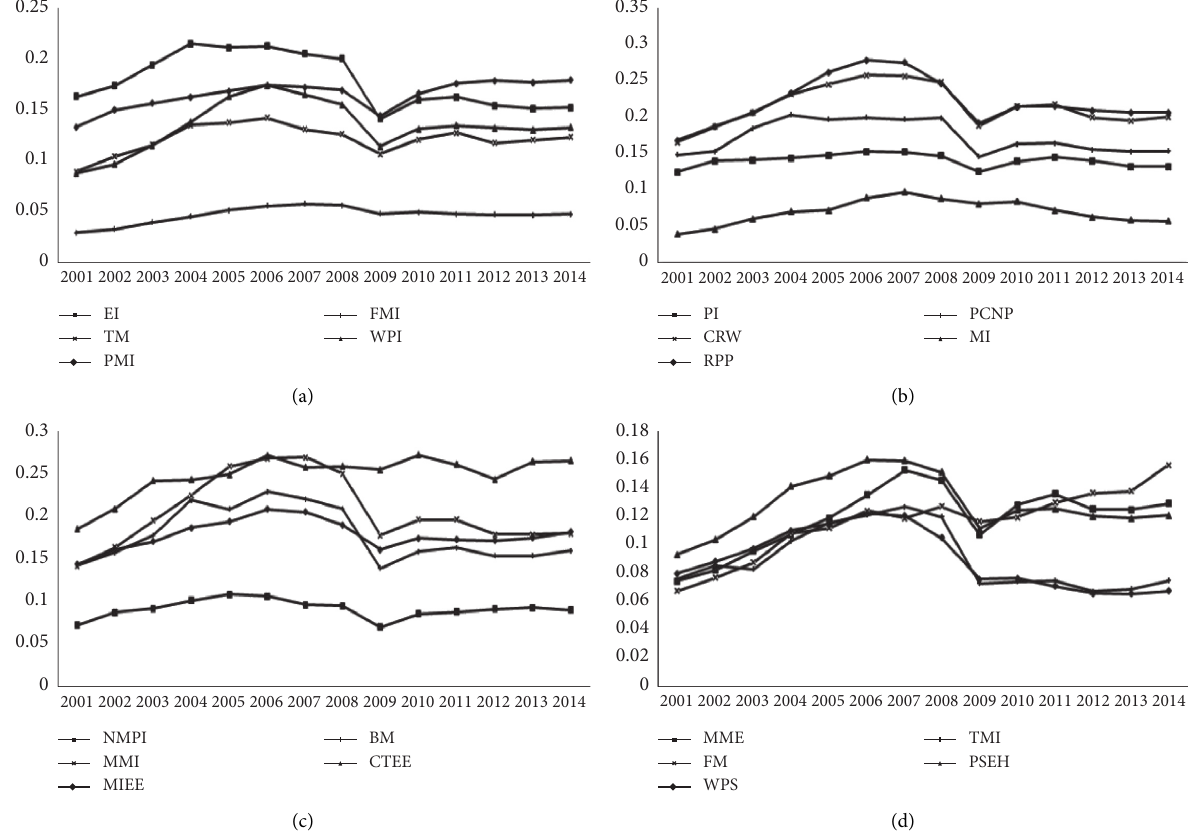
Figure 3: The trends of GVC participation of various industrial sectors in China from 2001 to